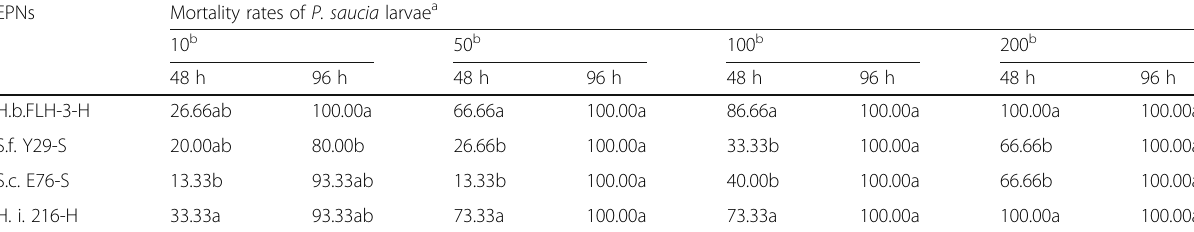
Table 1 The effect of different concentrations of EPNs on the mortality of last instar larvae of P. saucia for 48 and 96 h post application at 25 ± 1